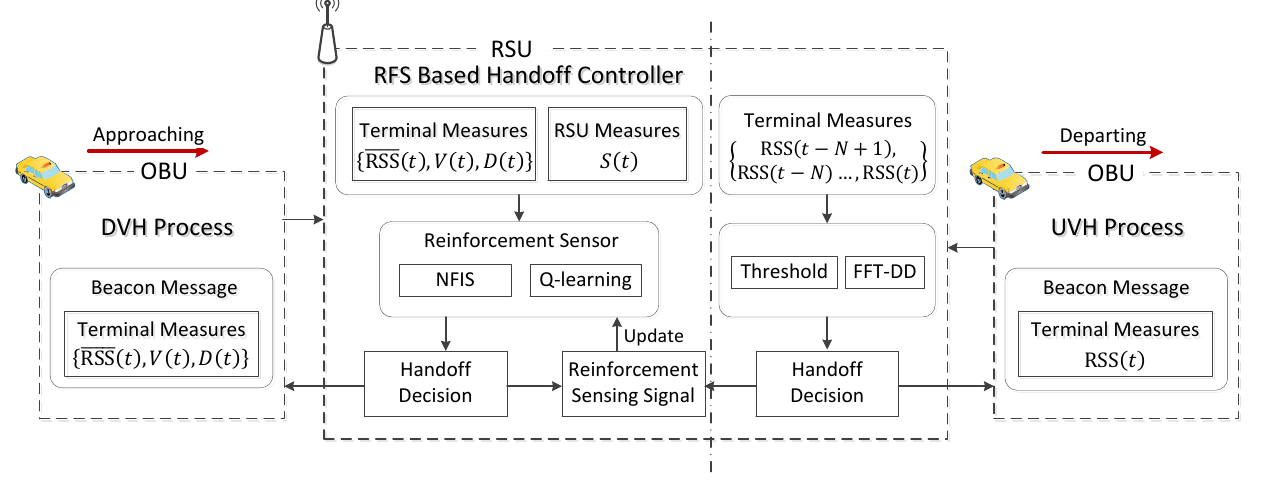
RFS Based Handoff Controller